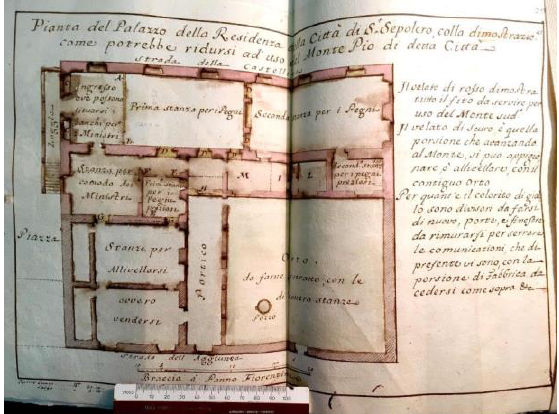
Figure 3. Map of the state of the places and works planned for the settlement of Monte dei Pegni, mid XVIII century (Paola Benigni, in